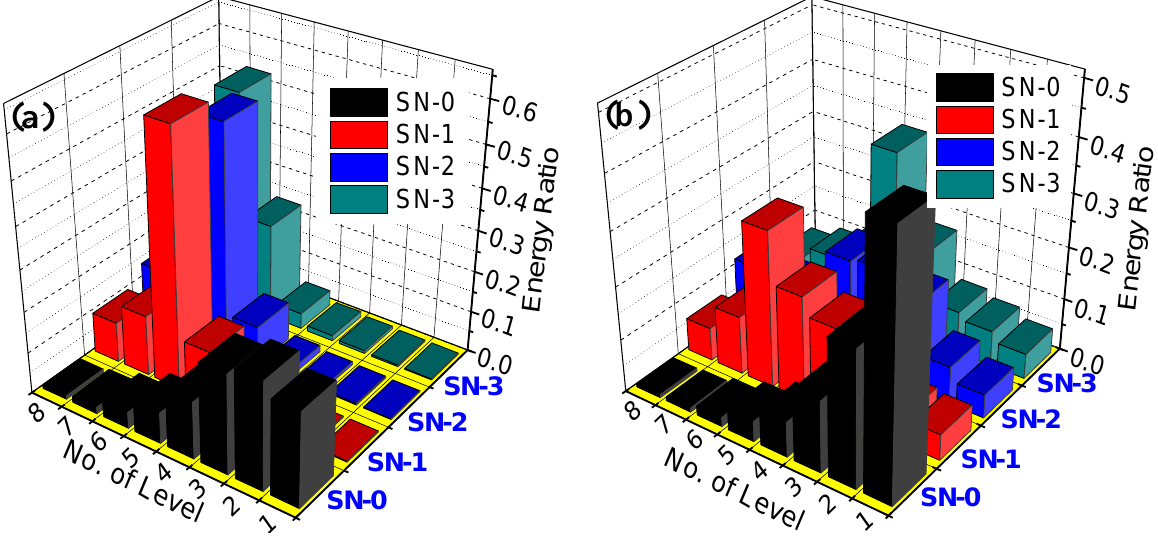
Figure 8. Energy distribution plots of the electrochemical emission signals in wavelet domain. ( a ) and ( b ) are the energy distribution plots of the electrochemical potential emission and electrochemical current emission,